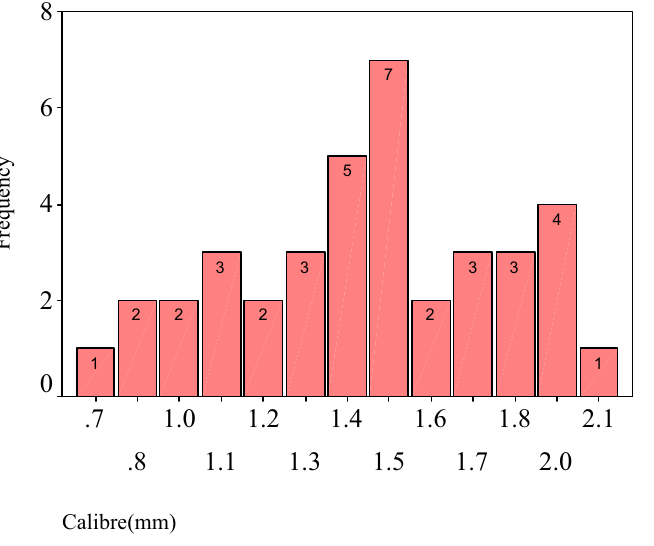
FIGURE 2 - Pedicle caliber of SIEA (n=38)